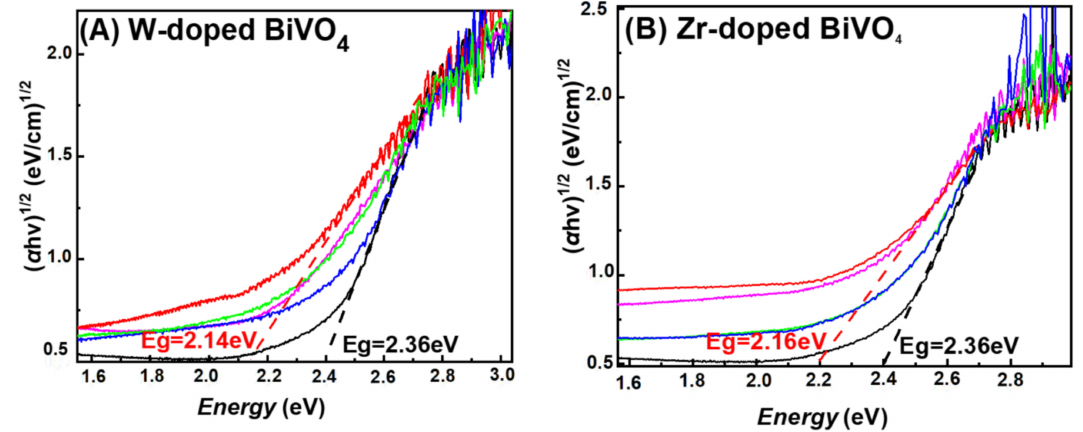
Figure 4. Kubelka–Munk transformed diffuse reflectance UV–Vis spectra of FSP-made BiVO 4 -based nanocatalysts. ( A ) W-doped BiVO 4 and ( B ) Zr-doped BiVO 4.